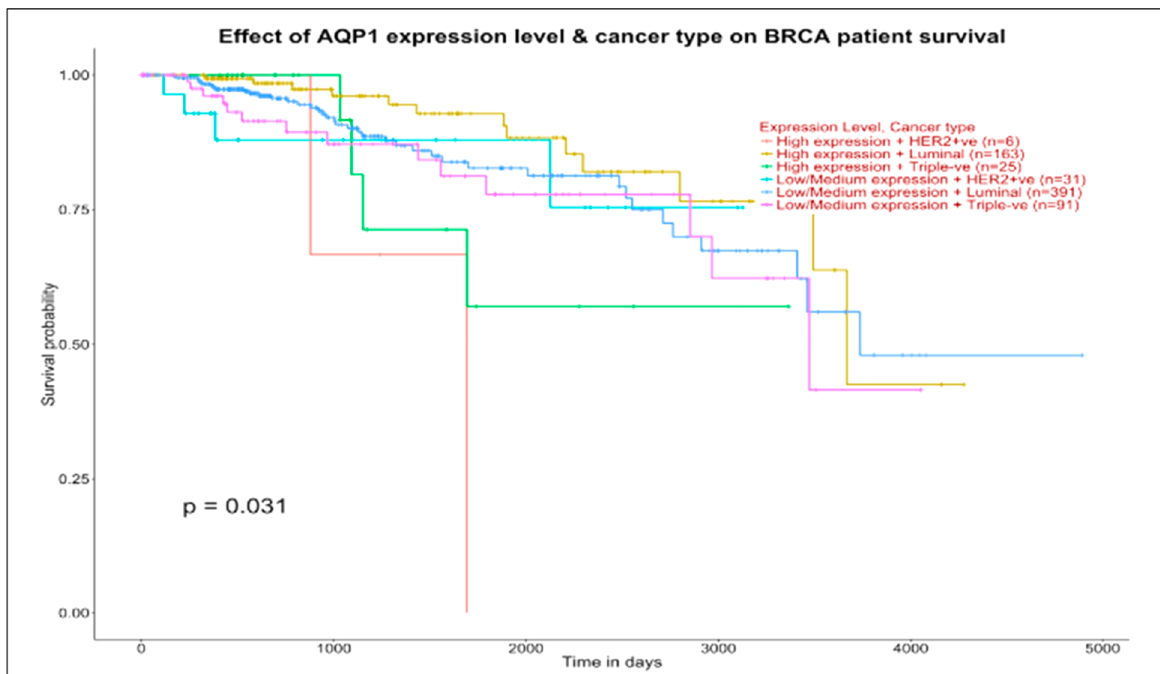
Figure 5. Basal selections with prognostic impact on breast invasive carcinoma (BRCA) patients. Source: UALCAN. Significance of survival impact is measured by log rank test (the lower the p -value, the better the separation between groups).